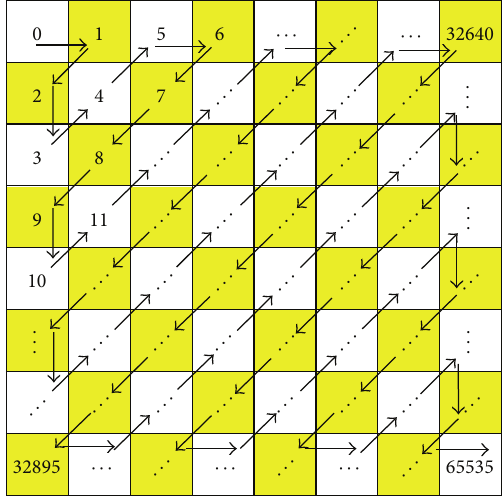
Figure 8: Zigzag order of 256 × 256 image